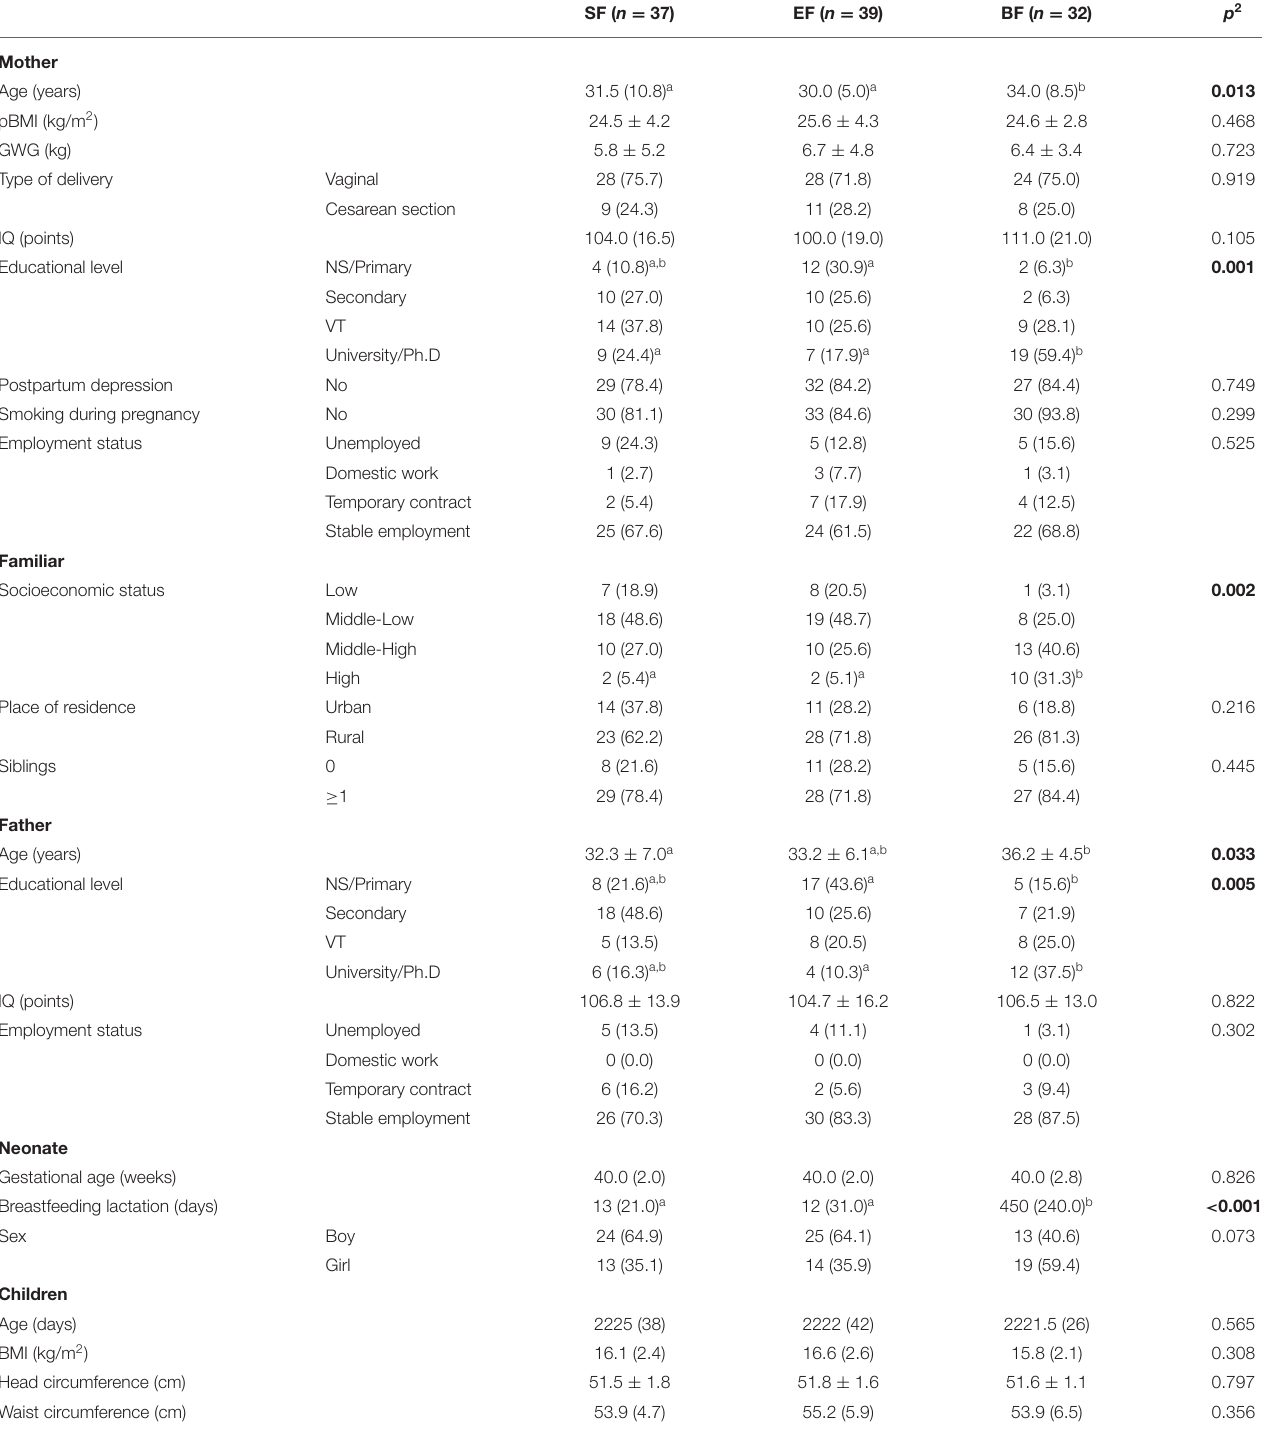
TABLE 1 | Baseline characteristics of parents and children participating in the COGNIS study depending on their type of feeding during infancy 1